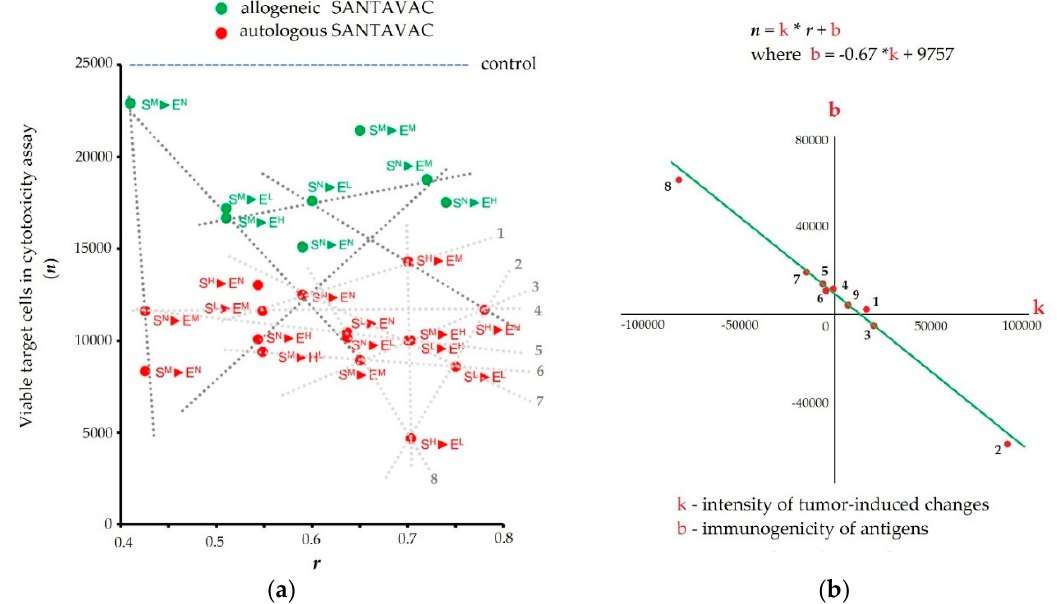
Figure 5. Cytotoxicity of effector CTLs against target human microvascular endothelial cells (HMECs). ( a ) Cytotoxicity plotted vs . correlation of SANTAVAC composition (code) and cell surface profile (footprint) of target cells. The average number of viable target cells in three wells is presented. Correlation coefficients ( r ) were calculated for SANTAVAC code and footprint of target HMECs (i.e., SANTAVAC/target similarity). ‘1 x ► 2 x ’: First letter corresponds to SANTAVAC and HMECs used as a source of antigens to produce this SANTAVAC (superscript), and the second letter corresponds to the target HMECs used in the cytotoxicity assay. Red and brown letters correspond to autologous and allogeneic antigens, respectively. Letters are used to identify HMECs stimulated to grow in the presence of an EC growth supplement (N), MCF-7 cell-conditioned medium (M), LNCap cell-conditioned medium (L), or HepG2 cell-conditioned medium (H). Data were scaled to bring all controls to equal values (25,000 cells, see ‘control’ line). Dashed lines show examples of linear dependence ( n = k ∗ r + b ) between cytotoxicity assay data n and r . All data in the plot were described by linear equations, and variations of the coe ffi cients ( k and b ) were interdependent. ( b ) Coe ffi cients of linear equations that describe the dependence of cytotoxicity on r . “ k ” and “ b ” values correspond to coe ffi cients of linear approximations showed on plot a. Equation of linear approximation of the coordinates is shown on the plot. Adapted from [90,91].